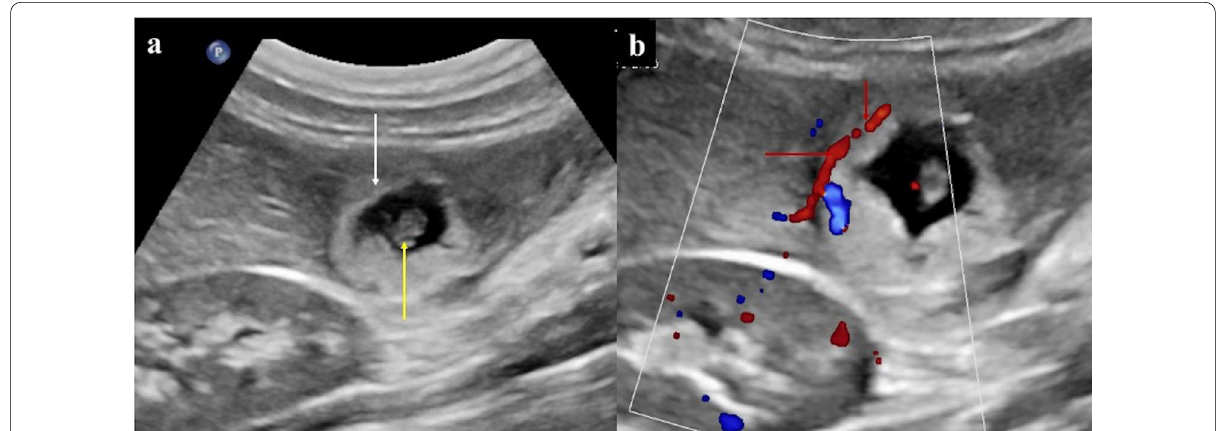
Fig. 1 a Transabdominal ultrasound (USG) image showing gestational sac (white arrow) with embryonic pole-yolk sac complex (yellow arrow). Gestational sac is attached to the inferior surface of Segment VI of liver with surrounding peri-gestational hematoma. b Transabdominal color Doppler image showing gestational sac is getting blood supply from the posterior segmental branch of the right hepatic artery (red